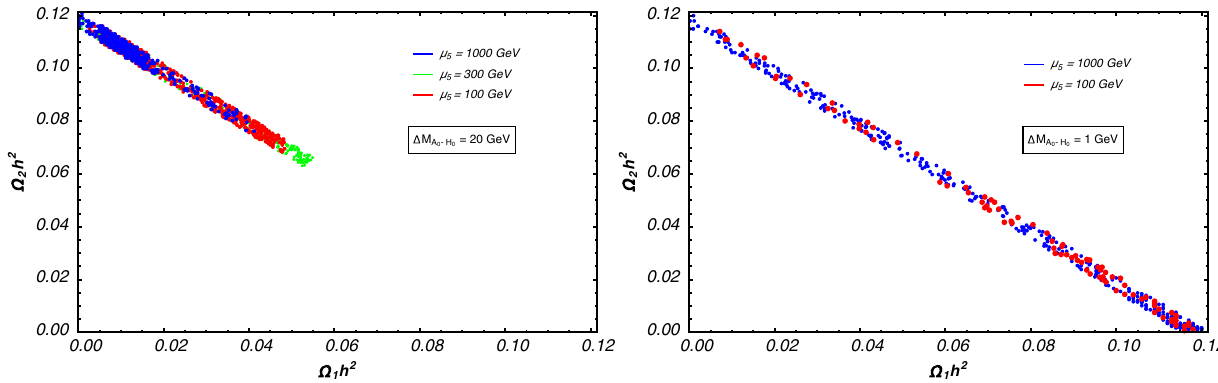
Fig. 10 Correlation between (cid:13) 1 h 2 and (cid:13) 2 h 2 for points satisfying total relic density bound for illustrative values of μ 5 . Two different mass splitting = 1 GeV (right) and 20 GeV (left) of the IDM neutral Higgs bosons show the importance of co-annihilation channels of (cid:15) M A 0 − H 0